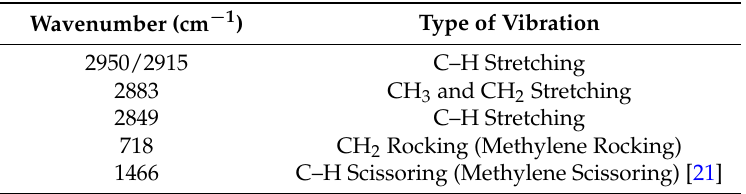
Table 1. FTIR assignments of the commercial feedstock.